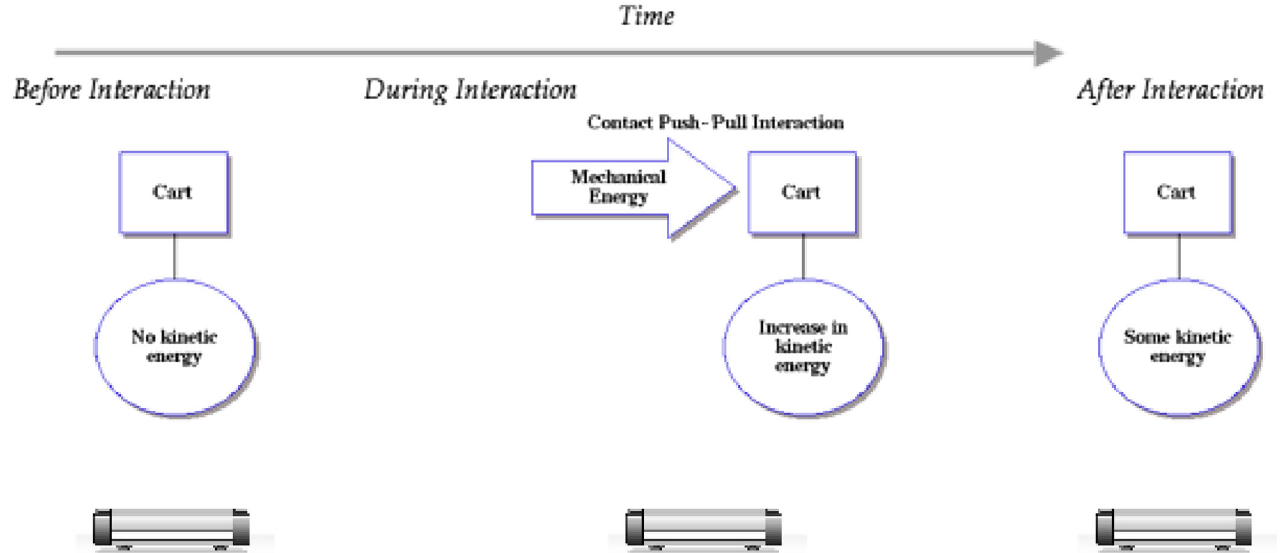
FIG. 3 (color online). Energy diagrams before, during, and after the cart is pushed. Students are asked to sketch the corresponding force diagrams.